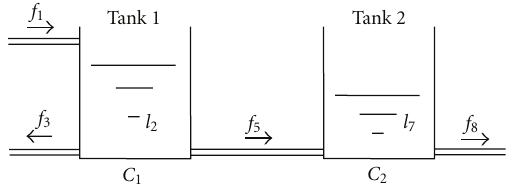
Figure 2: Schematic of a bitank system. C 1 and C 2 are cross- sectional areas of the two tanks, respectively.